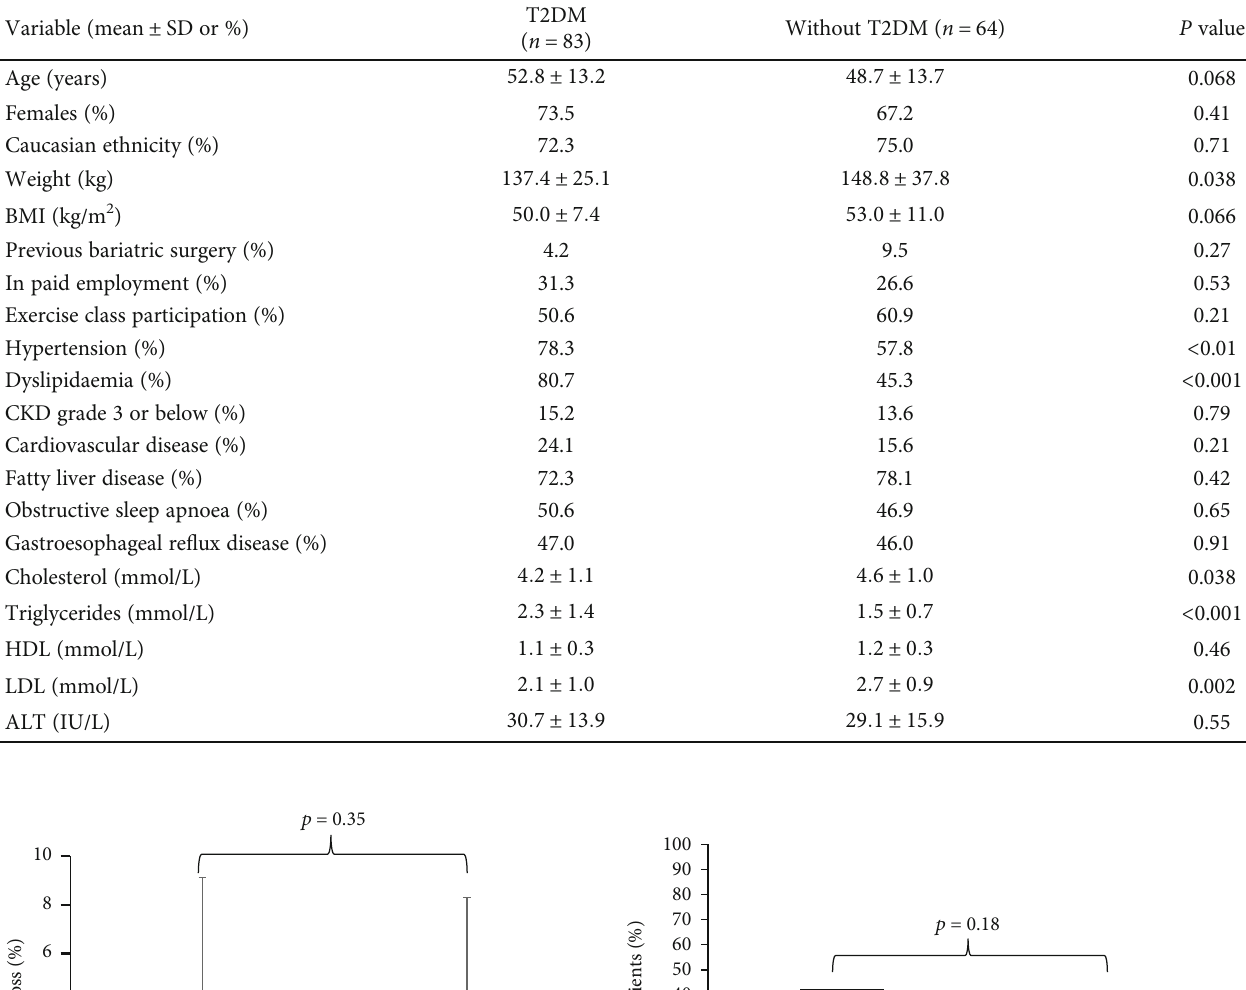
Table 1: Baseline characteristics of patients that were followed up at 6 months, by T2DM status at baseline.